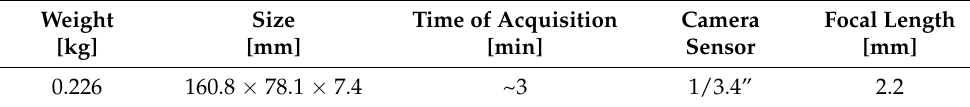
Table 3. Main characteristics of the iPhone 12 Pro Max TM .